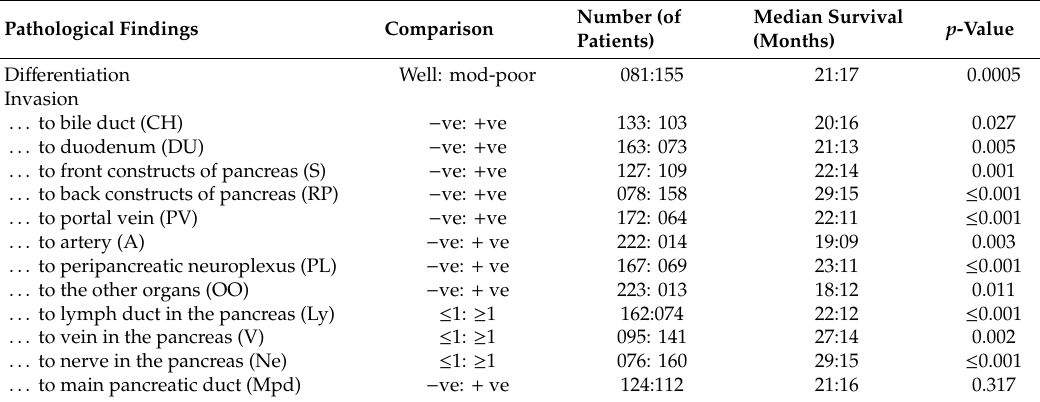
Table 2. Clinicopathological analysis and patient